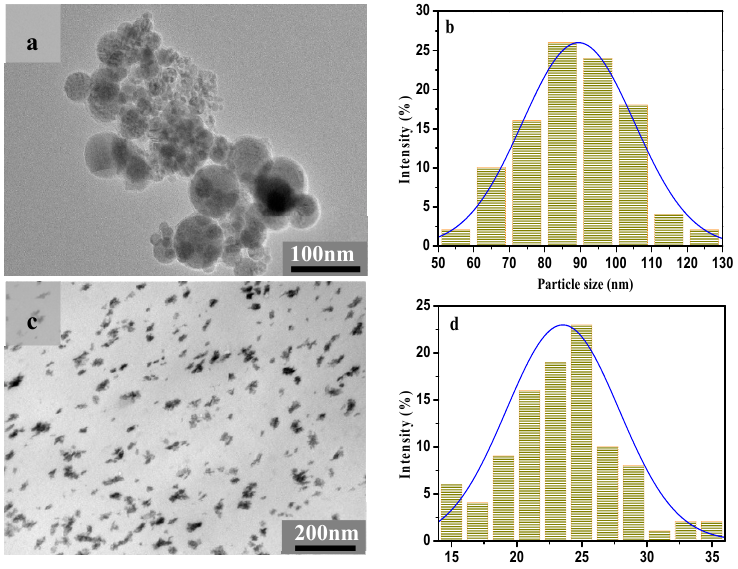
Figure 3. ( a ) TEM image of CeO 2 NPs formed outside the film; ( b ) particle size histograms of CeO 2 NPs corresponding to (a); ( c ) TEM image of the cross-section of cellulose/CeO 2 nanocomposite films; ( d ) particle size histogram of CeO 2 NPs estimated from ( c ). (Two samples were generated form 0.2 mol/L aq. Ce(NO 3 ) 3 ·6H 2 O solution).